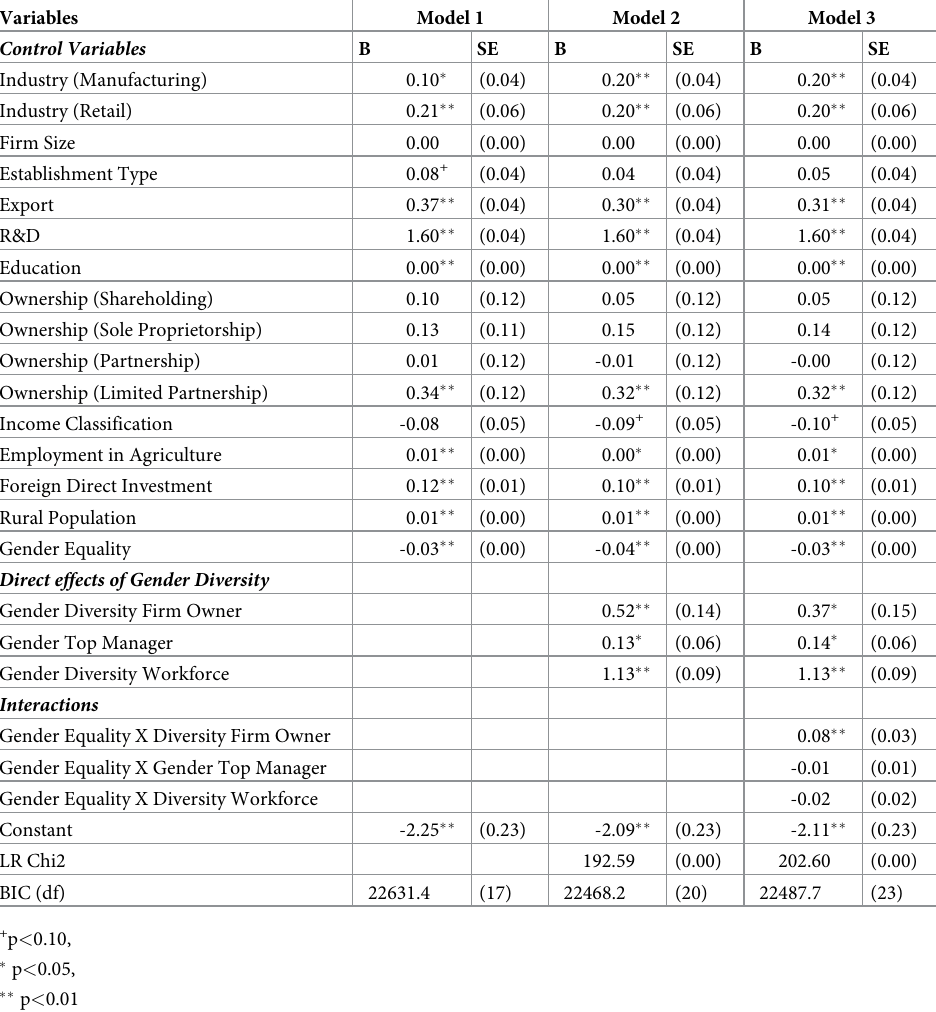
Table 3. Binary logistic regression models with clustered standard errors: Effect of gender diversity and the inter- action effect between gender diversity and gender equality on innovation (n = 18 547).